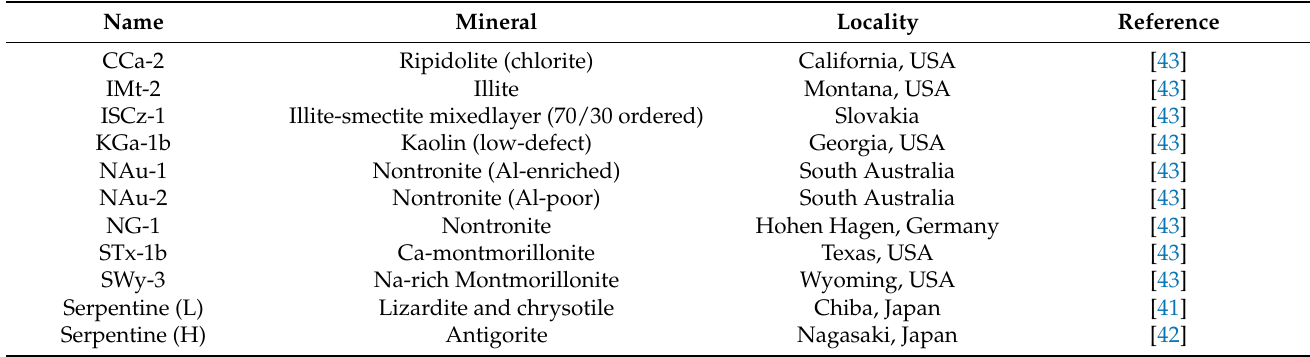
Table 2. Description on the reference clay